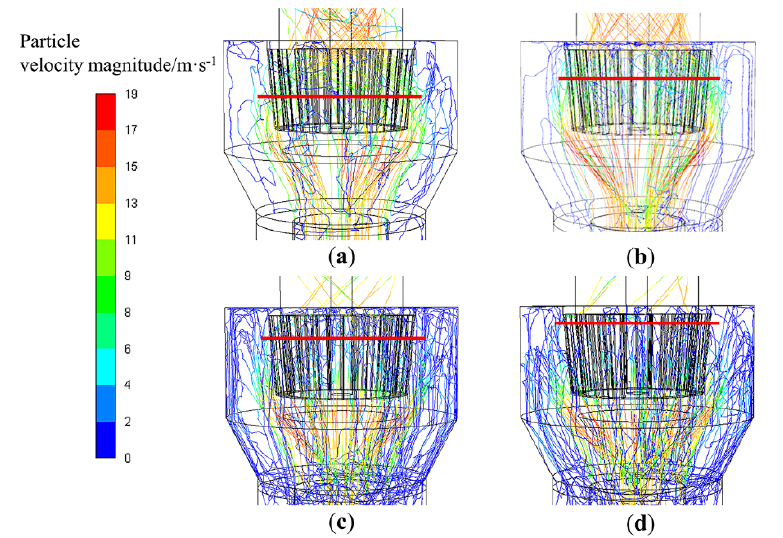
Figure 9. Trajectories of different size particles in T-B (1-0.9) : ( a ) d = 5 μ m, ( b ) d = 15 μ m, ( c ) d = 25 μ m, and ( d ) d = 35 μ m.